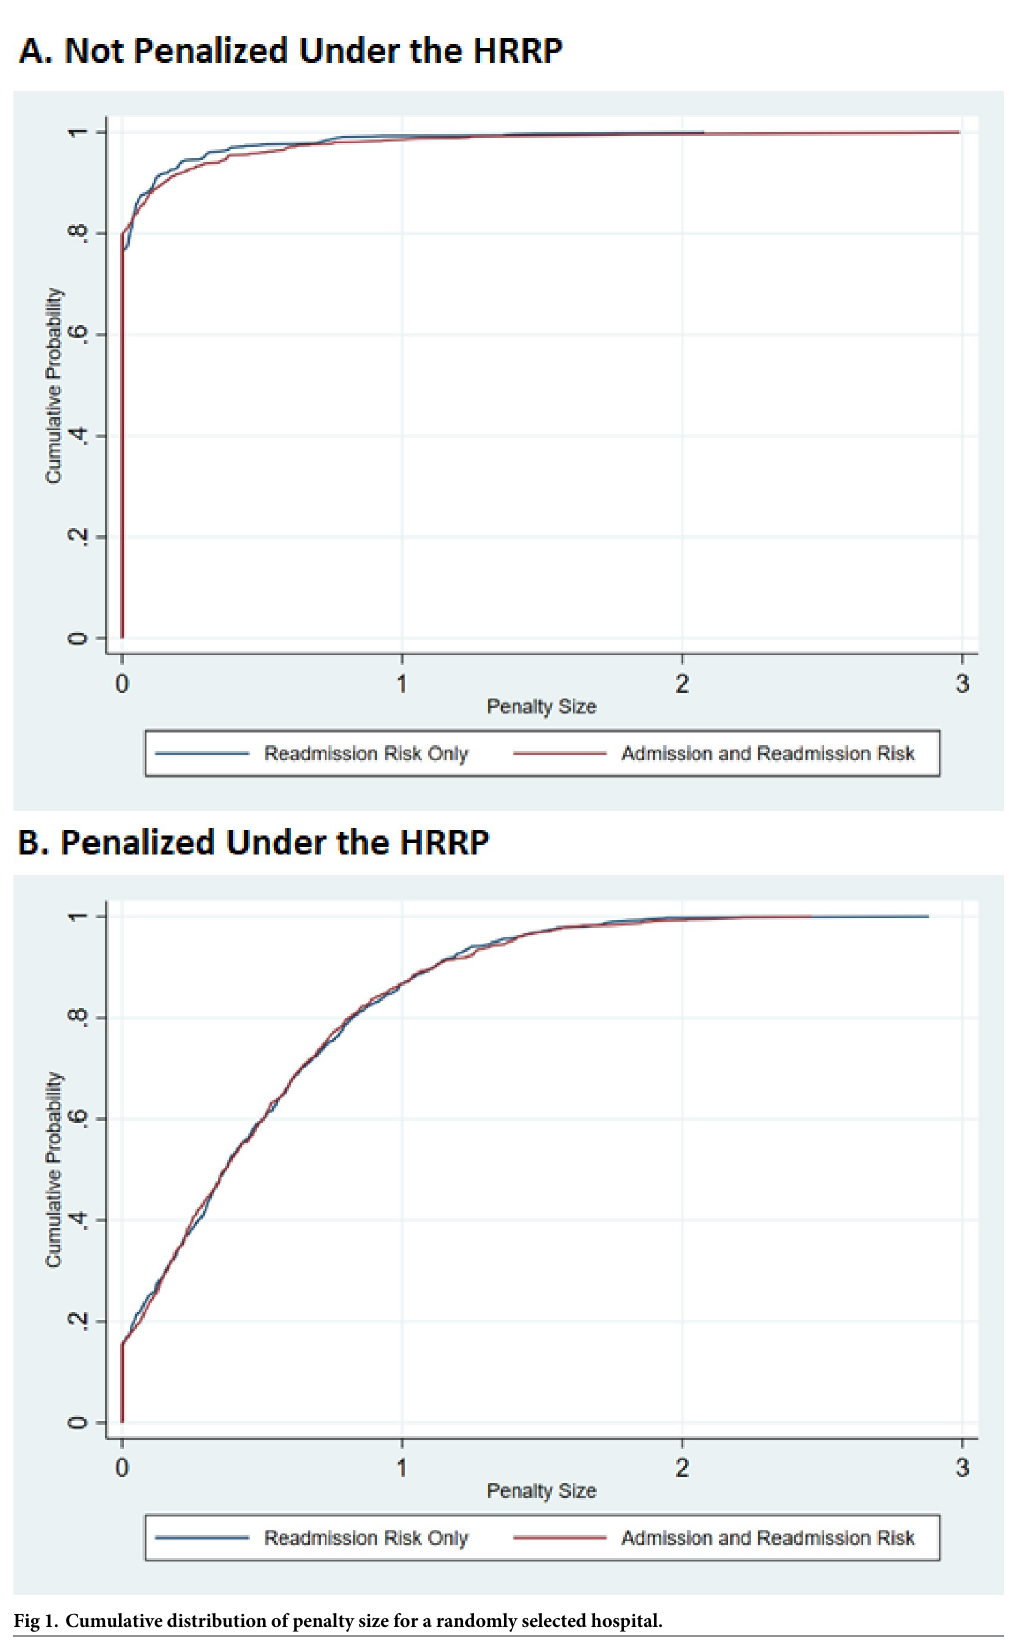
Fig 1. Cumulative distribution of penalty size for a randomly selected hospital.